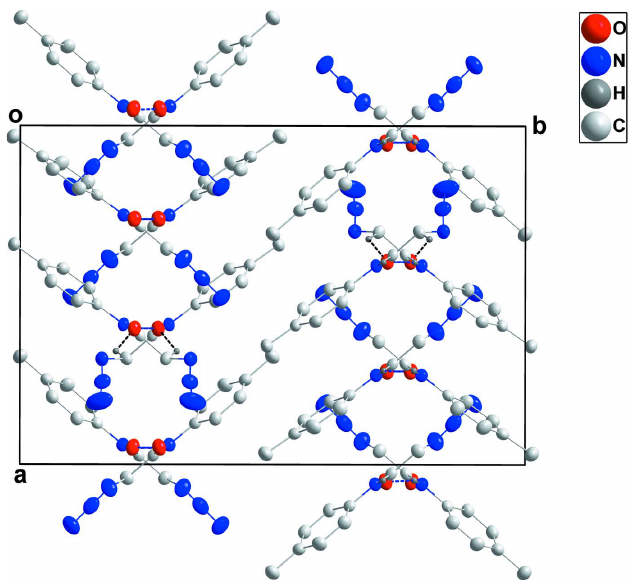
Figure 2 Packing viewed along the c -axis direction with N—H (cid:4)(cid:4)(cid:4) O and C—H (cid:4)(cid:4)(cid:4) O hydrogen bonds indicated, respectively, by blue and black dashed lines.